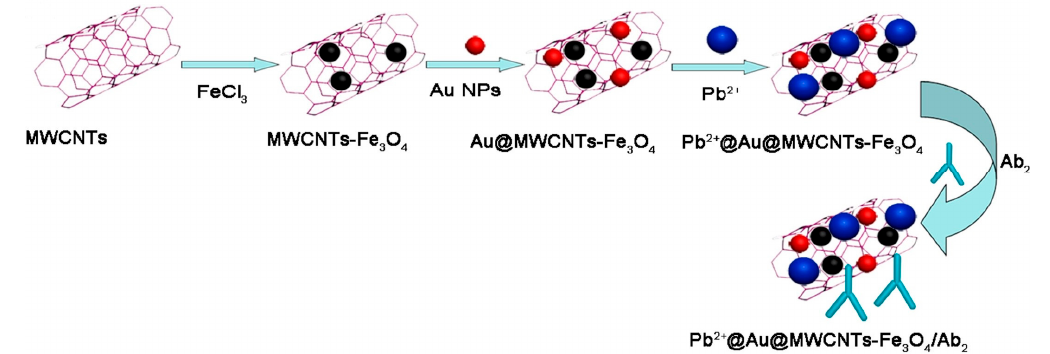
Figure 15. The preparation procedure of Pb 2+ @Au@MWCNTs-Fe 3 O 4 /Ab 2 . Reproduced with permission from [49].